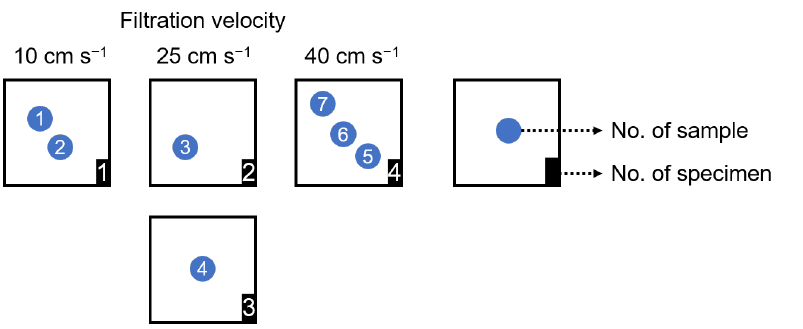
Figure 4. Schematic of the investigated specimens. The blue dots represent the locations of the taken samples, approximately in the center of the